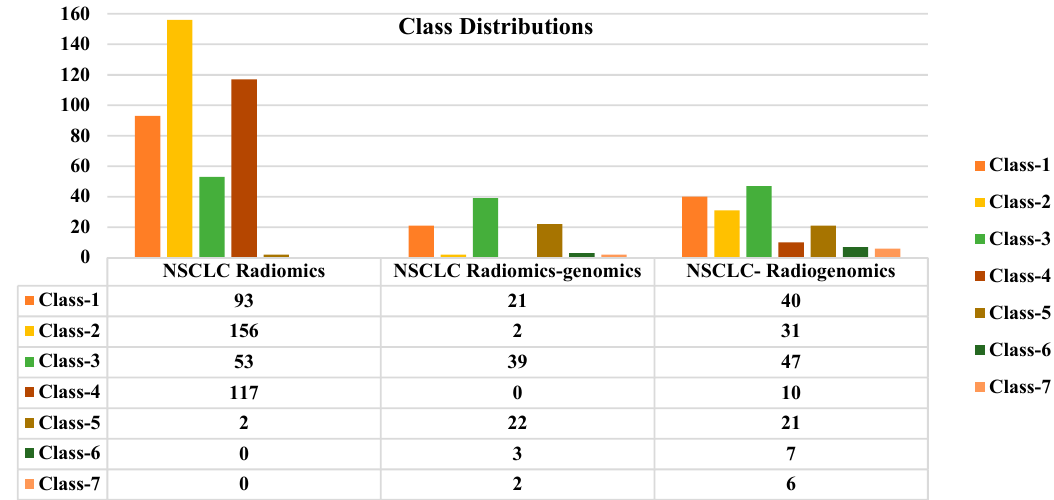
Figure 12. Class distribution of NSCLC datasets.